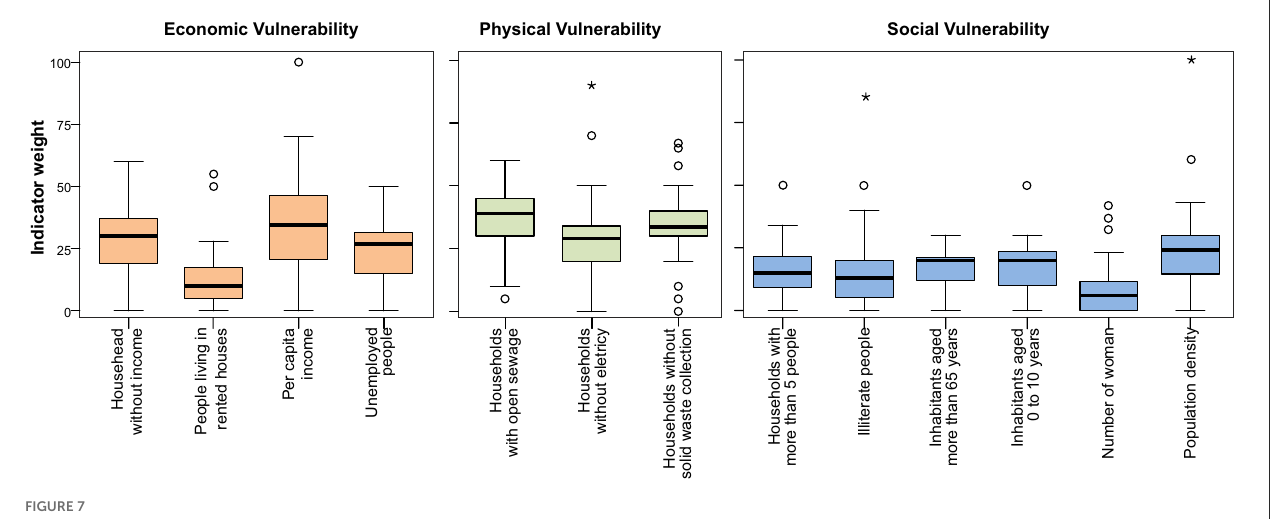
test showed that the population mean ranks of weights of indicators did not significantly differ among the stakeholders’